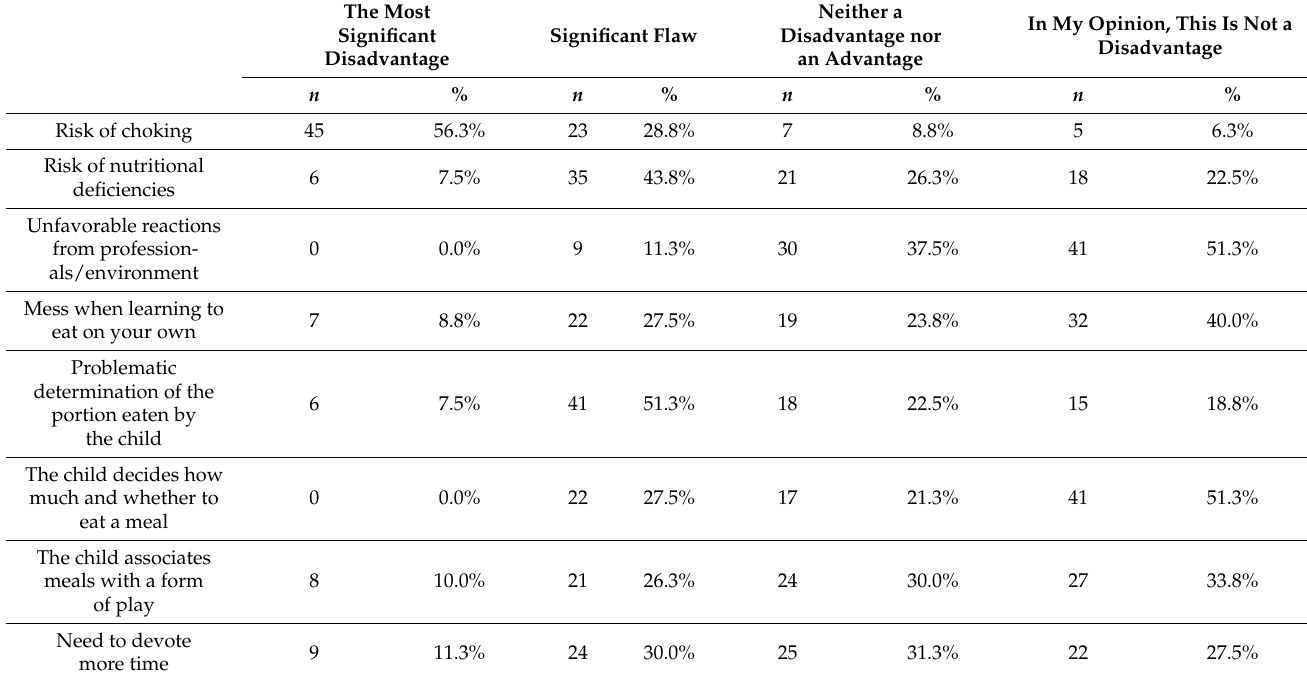
Table 7. Importance of BLW disadvantages in the group of mothers not using BLW ( n = 80).